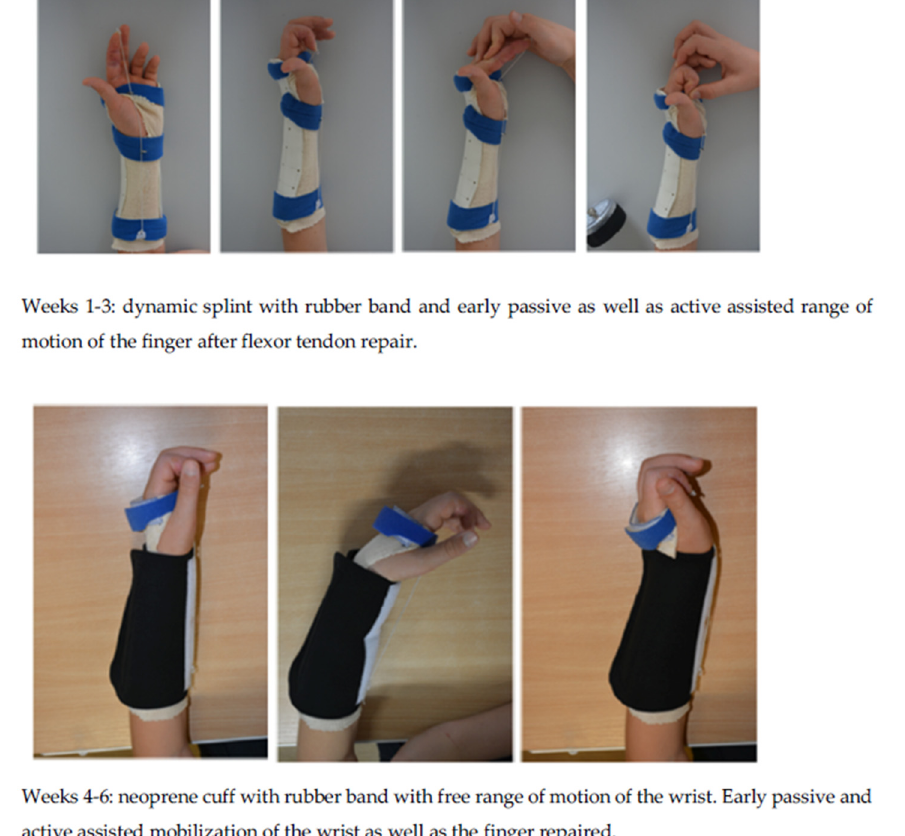
Figure 3. Our 12-week postoperative rehabilitation protocol in 3 steps.